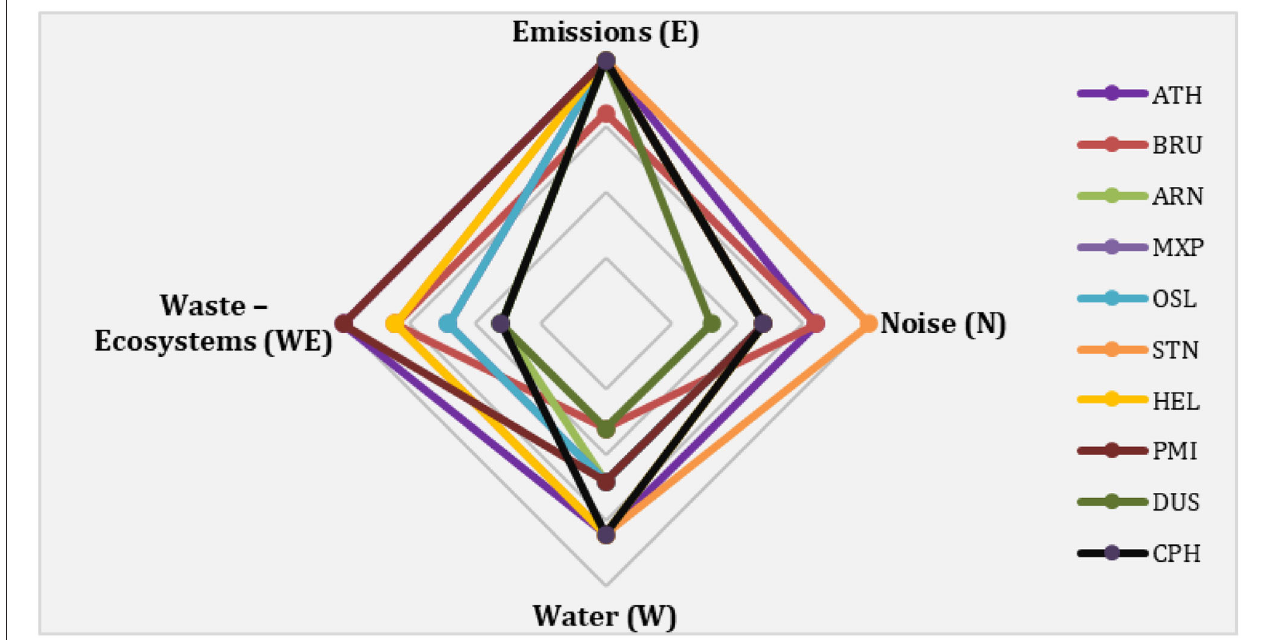
FIGURE 3 | Depiction of airports’ environmental management performance scores.